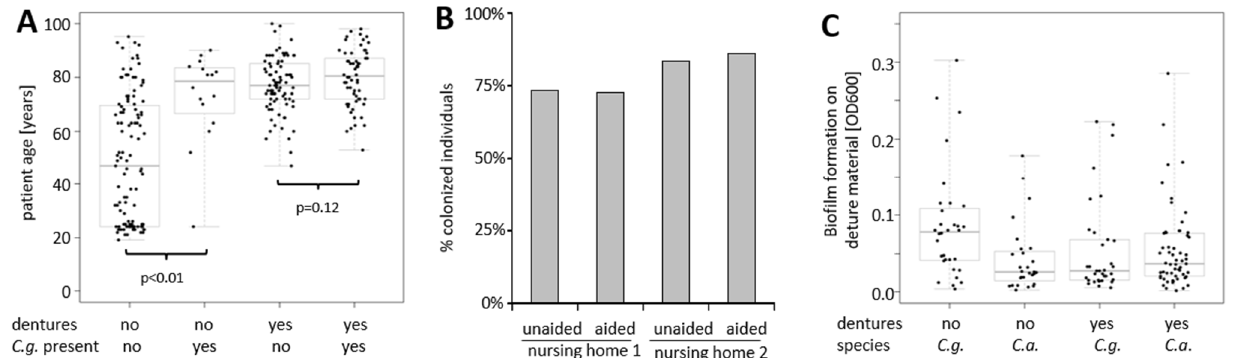
Figure 3. Factors potentially influencing oral colonization. ( A ) The influence of denture wearing and host age on colonization by C. glabrata . ( B ) The influence of receiving aid for dental cleaning on fungal colonization, and ( C ) the correlation of biofilm formation capacity of oral C. albicans and C. glabrata isolates on acrylic ester between non-denture wearers vs. denture wearers.